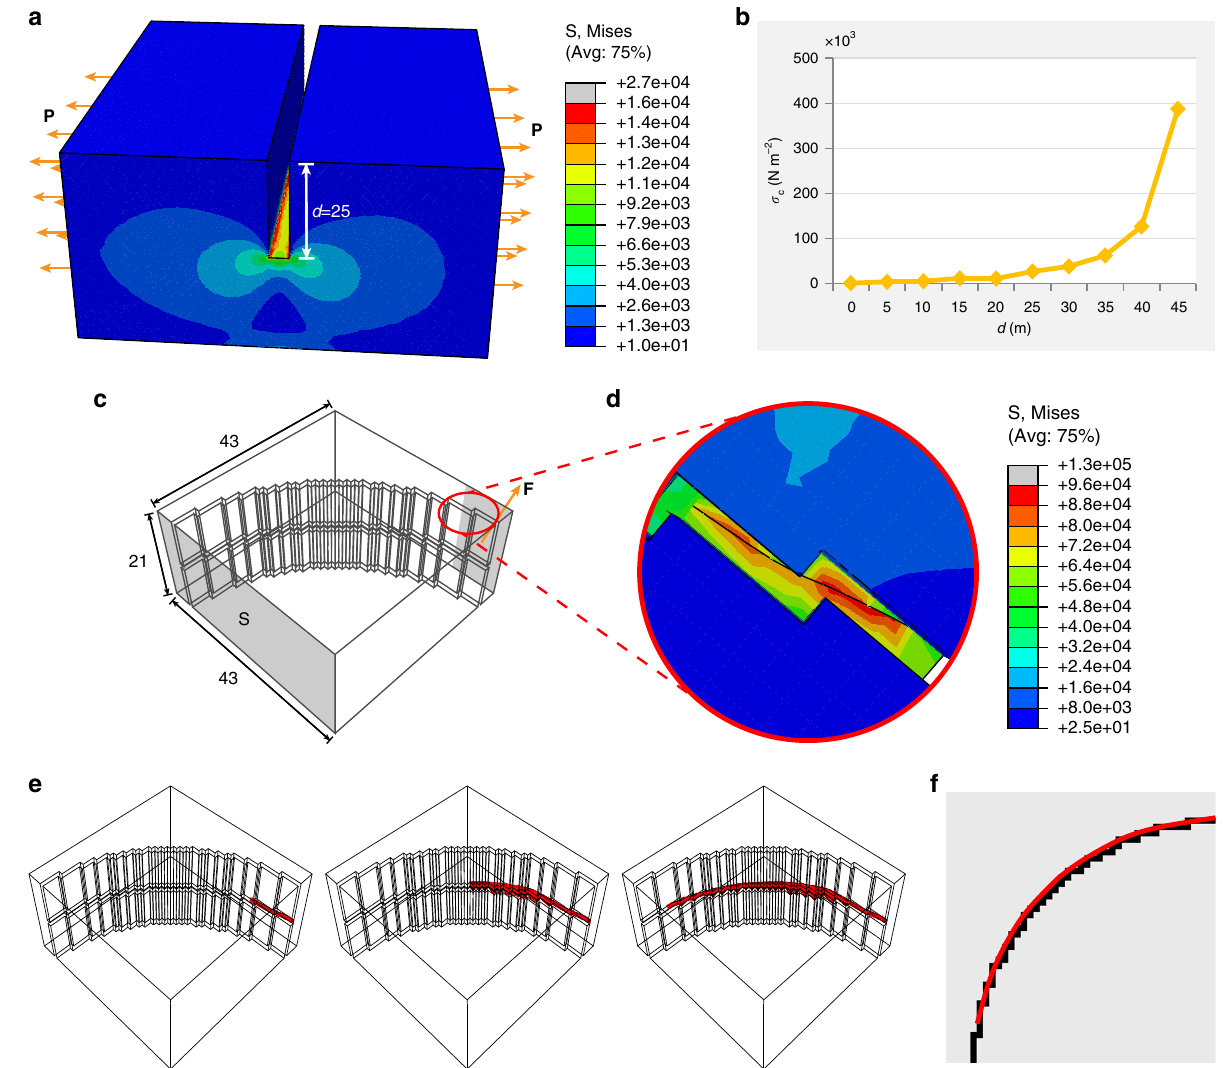
Fig. 2 Stress concentration and crack propagation. a The stress distribution of a three-dimensional model under a distributed pulling force P perpendicular to the groove. b The trend of the maximum stress as the groove-depth increases of the model in a . c A thin- plate model with a groove transformed from a quarter-circle boundary. The shadow surface S on the left is fi xed. d The stress distribution and the generated crack of the model enclosed by the red circle in c under external load F . e Crack-surface propagation process in the model. f The fi nal boundary obtained after a crack-propagation procedure shown in e . Different colors in the scale bar in a , d represent different stress values (N m − 2